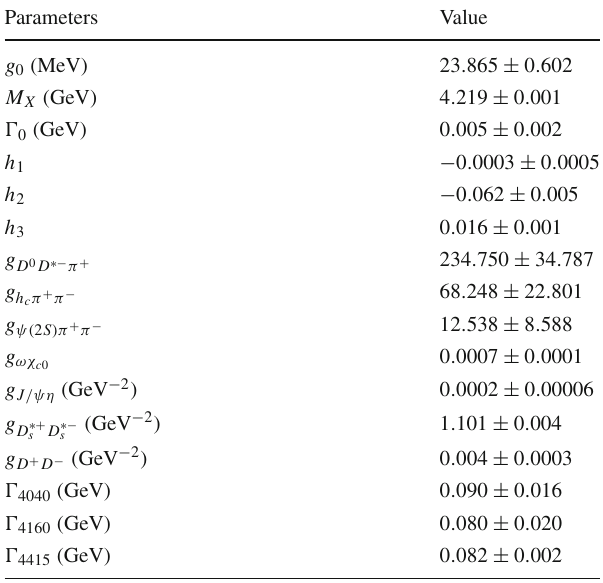
Table 1 Summary of numerical results associated with the D ∗+ s D ∗− s